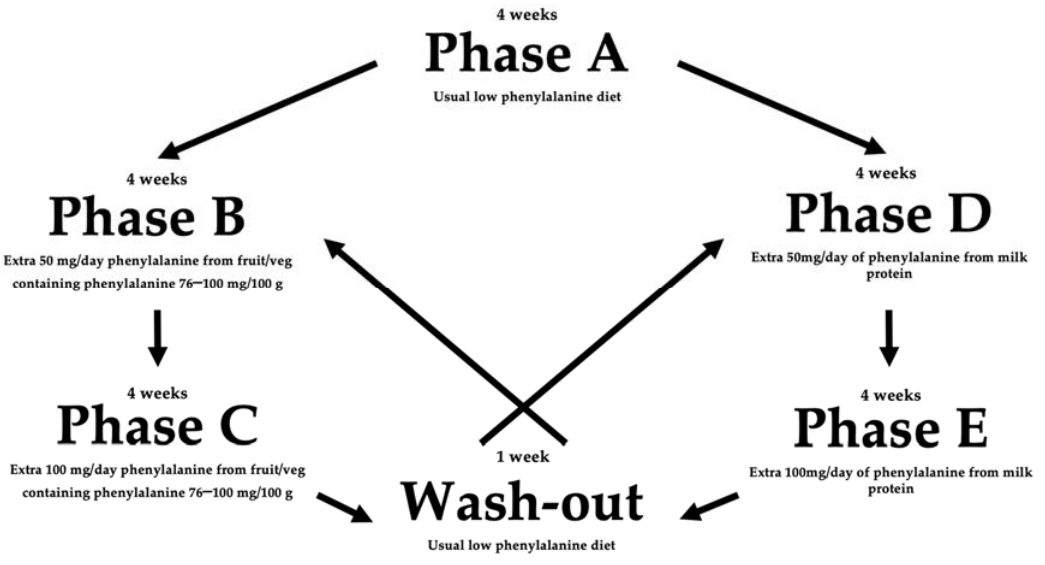
Figure 1. Randomized controlled crossover study design.